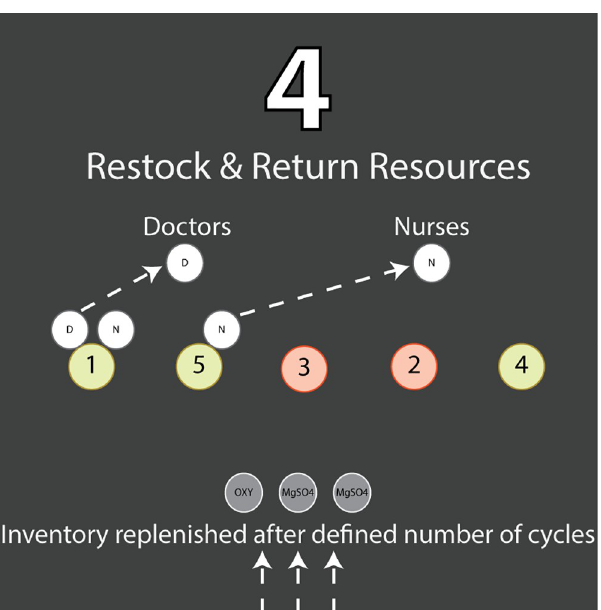
Fig 4. Schematic of the fourth and final step in the algorithm, before the four steps are repeated for the next fifteen minute cycle—medications are restocked if necessary, and any doctors or nurses that were treating patients in the current cycle but are not required for treatment in the next cycle are returned to the staff pool to be re-allocated in the following cycle.